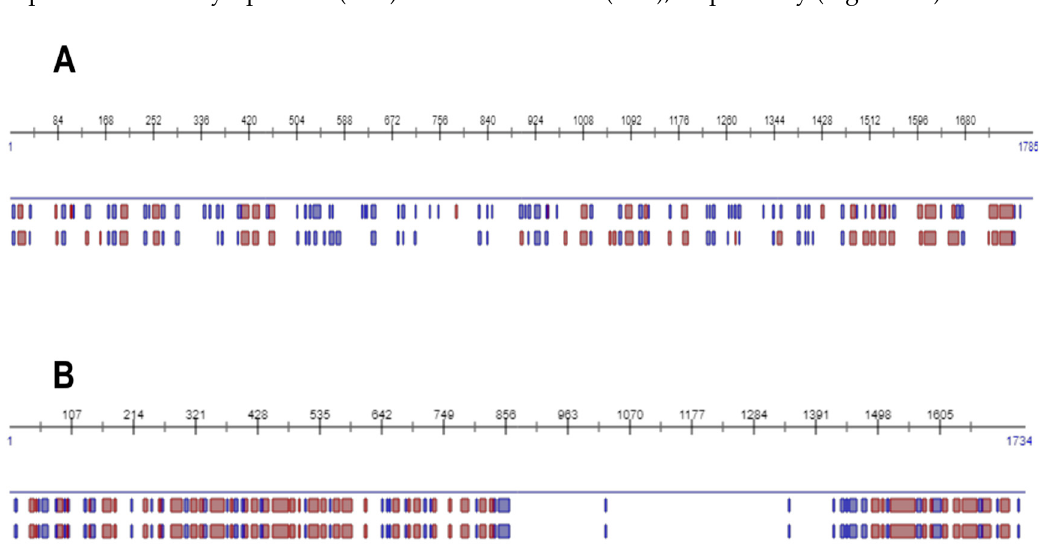
Figure 3. Secondary structure content of Leishmania (V.) braziliensis subtilisins. The sequences of the subtilisin LbrM.13.0860 ( A ) and LbrM.28.2570 ( B ) were analyzed by the PredictProtein server. The predicted secondary structures are colored blue ( β -strands) and red ( α -helices).